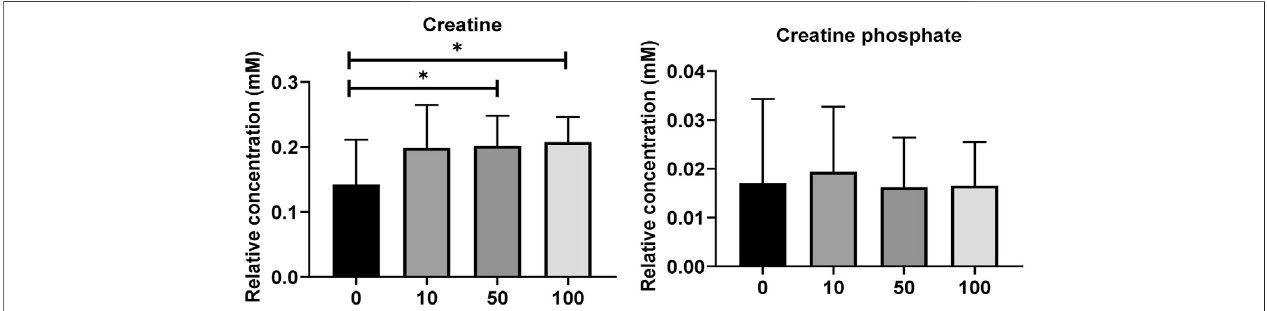
FIGURE 4 | (A) Levelofsigni fi cantlydysregulatedcreatineandcreatinephosphateinzebra fi sh. (B) Thetop15mostmetabolicdiscriminatingmetabolitesbetweenControl andSWCNT.VIPmetabolomeidenti fi edfrom fi shrelativetothecontrolsaftertheSWCNTtreatment.Themajorcontributingmetabolitesareidenti fi edusingPLS-DAalgorithm.The right heatmap shows the concentration of the metabolites. The middle part shows the VIP scores. The left part lists the signi fi cant difference between metabolites.